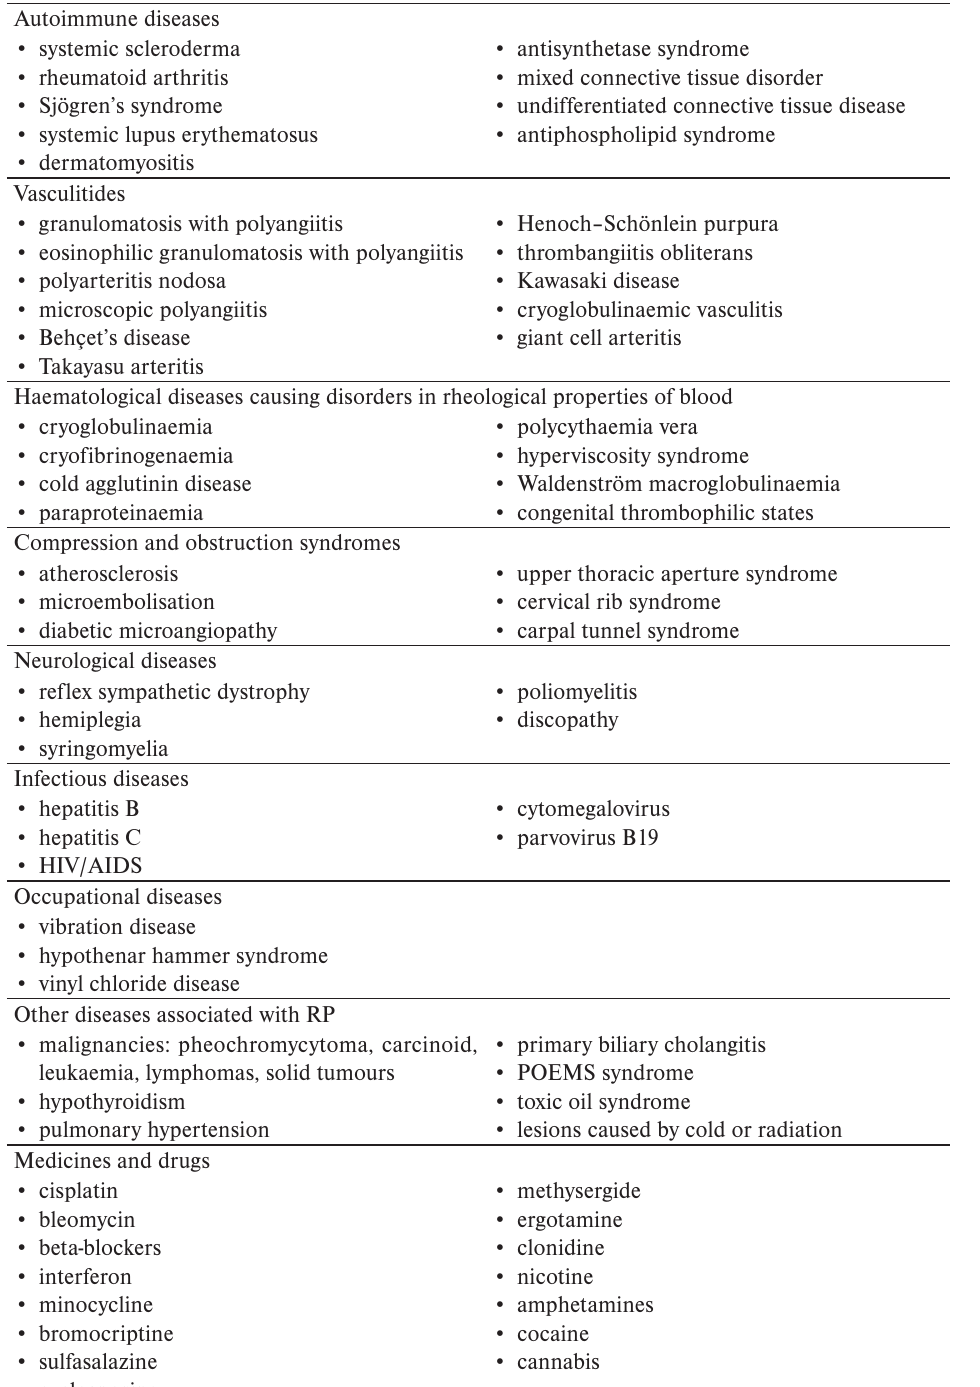
Table 1. Overview of the most frequent causes of SRP (ref. 6